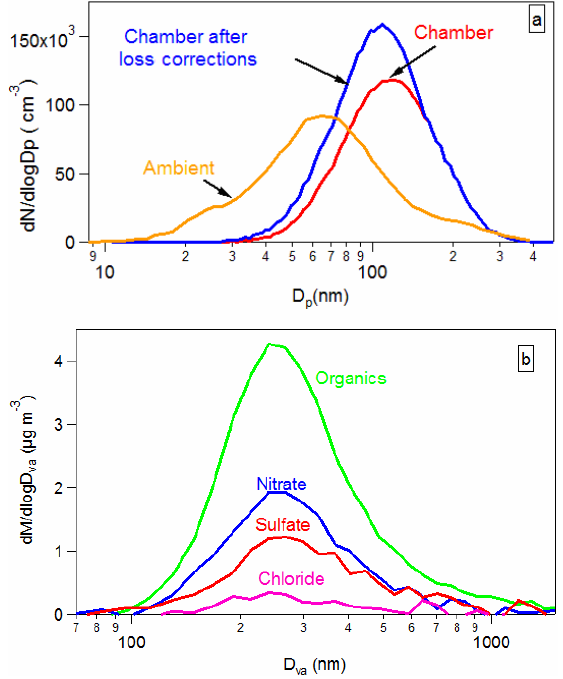
Figure 12. Size distributions: (a) SMPS distributions from experiment 1; the red line is Fig. 12. Size distributions: (a) SMPS distributions from experi- the size distribution as measured in the chamber at t=0 (mode diameter ~120 nm), the ment 1; the red line is the size distribution as measured in the cham- blue line is the reconstructed from the pump losses corrections size distribution for t=0 (mode diameter ~109 nm) and the orange line is the size distribution during an ambient ber at t = 0 (mode diameter ∼ 120nm), the blue line is the recon- fire event. (b) AMS mass distributions from experiment 1 (mode diameter ~240 nm). structed from the pump losses corrections size distribution for t = 0 (mode diameter ∼ 109nm) and the orange line is the size distribu- tion during an ambient fire event. (b) AMS mass distributions from experiment 1 (mode diameter ∼